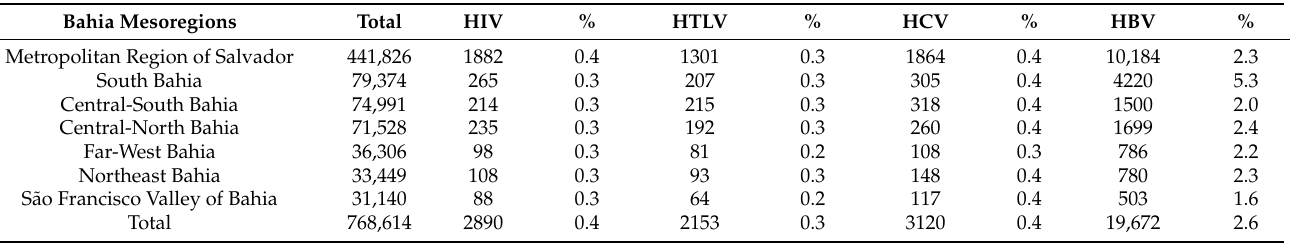
Table 6. Prevalence of HIV, HTLV, HCV and HBV infections by mesoregions of residence in the State of Bahia, from February 2008 to December